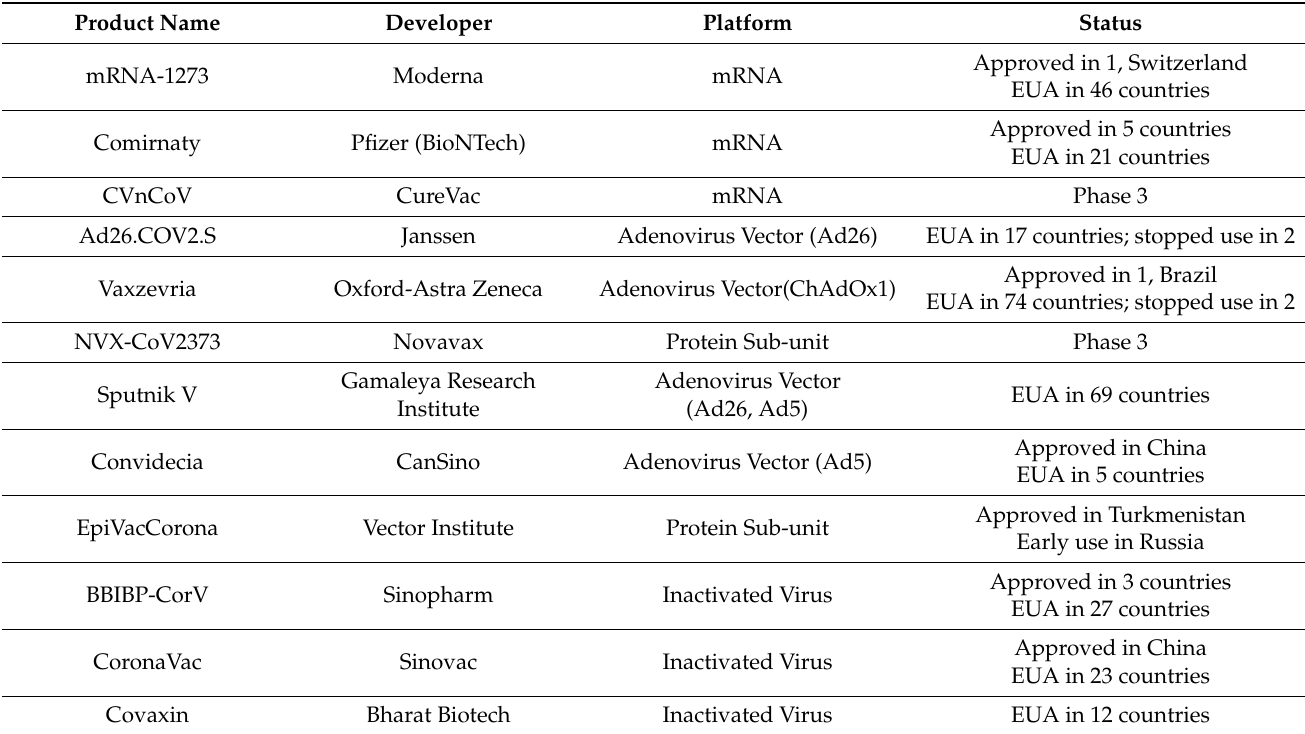
Table 1. Leading COVID-19